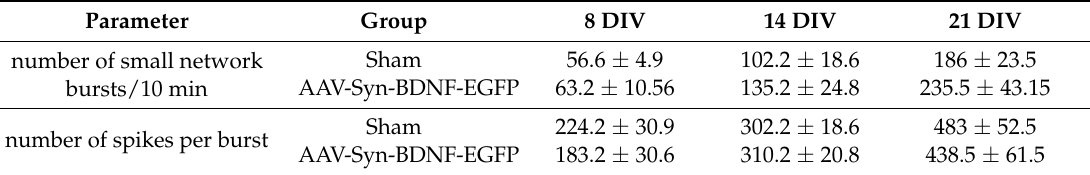
Table 1. Main parameters of spontaneous bioelectrical activity in primary hippocampal cell cultures. Parameter Group 8 DIV 14 DIV 21 DIV Sham 56.6 ± 4.9 102.2 ± 18.6 186 ± 23.5 number of small network AAV-Syn-BDNF-EGFP 63.2 ± 10.56 135.2 ± 24.8 235.5 ± 43.15 bursts/10 min Sham 224.2 ± 30.9 302.2 ± 18.6 483 ± 52.5 number of spikes per burst AAV-Syn-BDNF-EGFP 183.2 ± 30.6 310.2 ± 20.8 438.5 ±